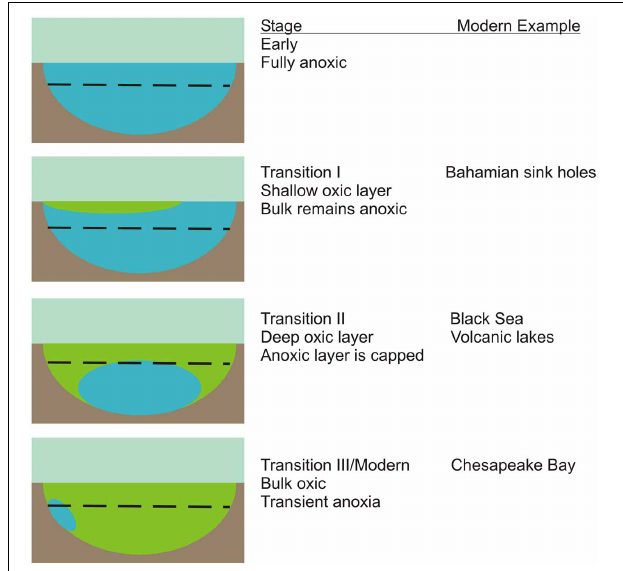
FIGURE 1 | A simplified conceptual model for the progressive transition from an early anoxic ocean (blue) to modern oxygenated oceans (green). The dashed line indicates the depth of the photic zone. The chemistry and microbiology of the transient anoxia that develops in the Chesapeake Bay on an annual basis will be used in this project as a proxy for the last transitional stage. The group has access to samples and data from the Black Sea chemocline and Bahamian sink holes that are thought to represent additional transition